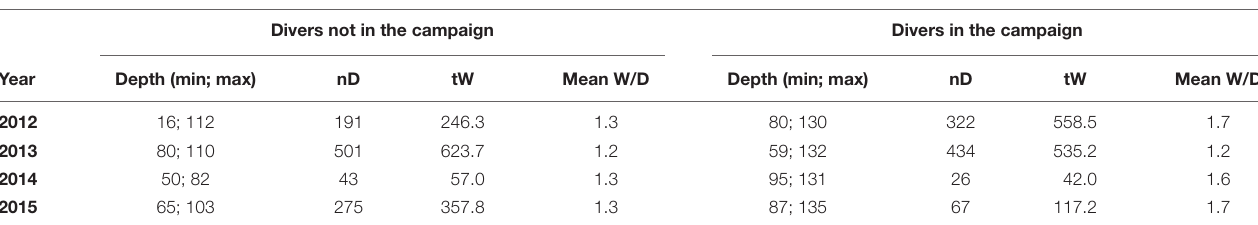
TABLE 3 | Logbook